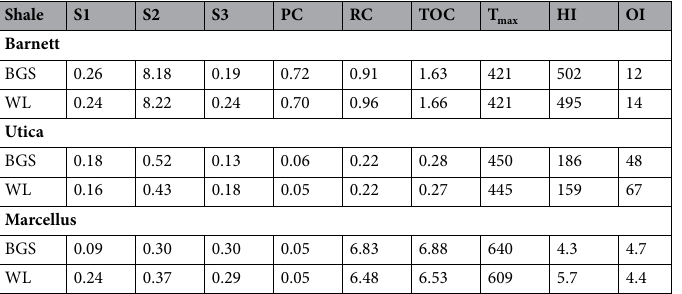
Table 3. Rock–Eval data. S1—volatile hydrocarbon (HC) content, mg HC/g rock. S2—thermally generated (cracked) hydrocarbon, mg HC/g rock. S3—CO 2 content, mg CO 2 /g rock. PC—content of hydrocarbons volatilized and pyrolyzed, wt%. RC—CO 2 generated during oxidation representing remaining carbon, wt%. TOC = PC + RC, wt%. HI—hydrogen index = S2 × 100/TOC, mg HC/g TOC. OI—oxygen index = S3 × 100/ TOC, mg CO 2 /g TOC. T max —temperature at which maximum of peak S2 occurs.